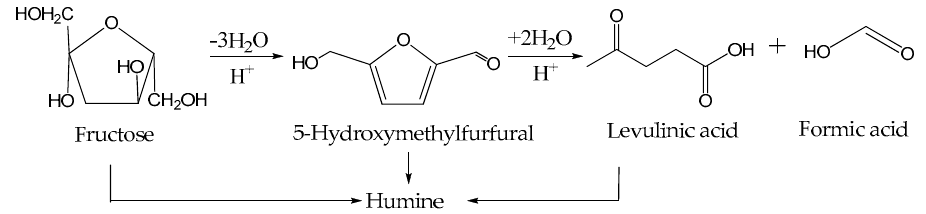
2 –SiO 2 and ZrO 2 –SiO 2 –SnO 2 samples.